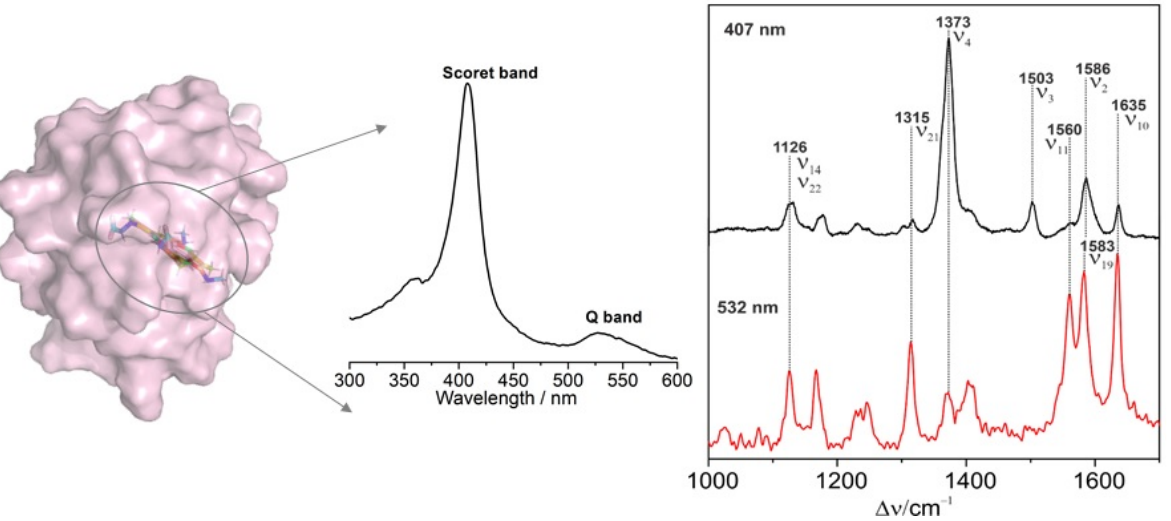
Figure 4. Absorbance (blue) and resonance Raman spectra of oxidized Cyt-c with 407 (black) and 532 nm (red) excitation, respectively [50]. Table 1. Band assignments of resonance Raman and denatured SERRS of Cyt-c, Cyt-b 5 and Mb